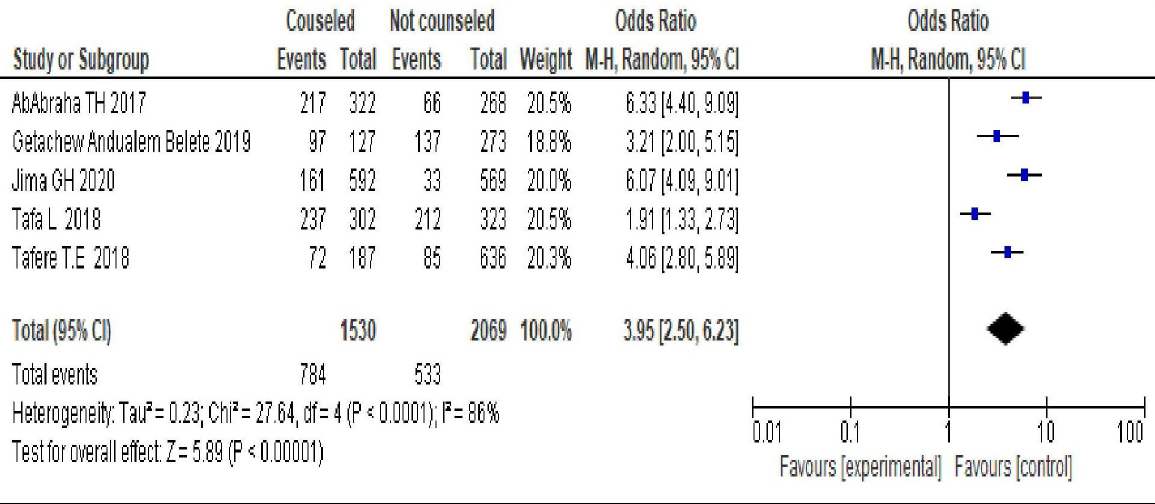
Fig 8. Association between postpartum family planning (PPFP) counseling during ANC follow-up and modern contraceptive uptake during postpartum period, 2021.